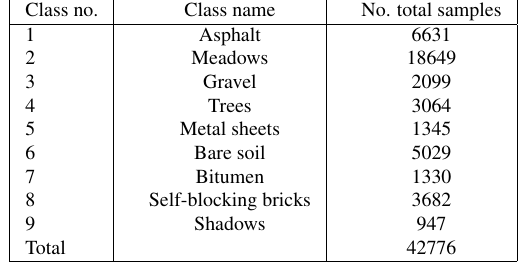
Table 3. Pavia university dataset: class numbers, class names, and number of observations for each class